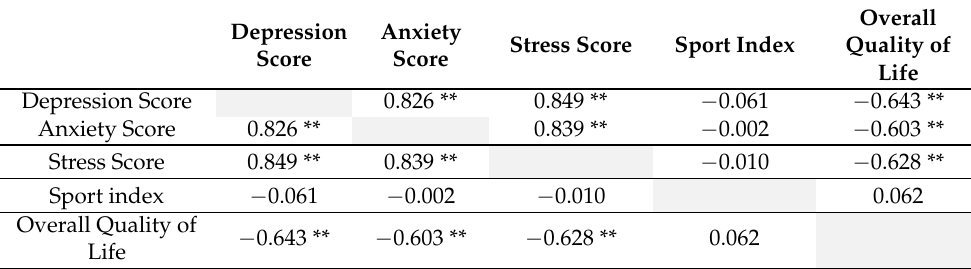
Table 4. Correlations between the overall quality of life, sport index, and the DASS21 domains among adolescents.